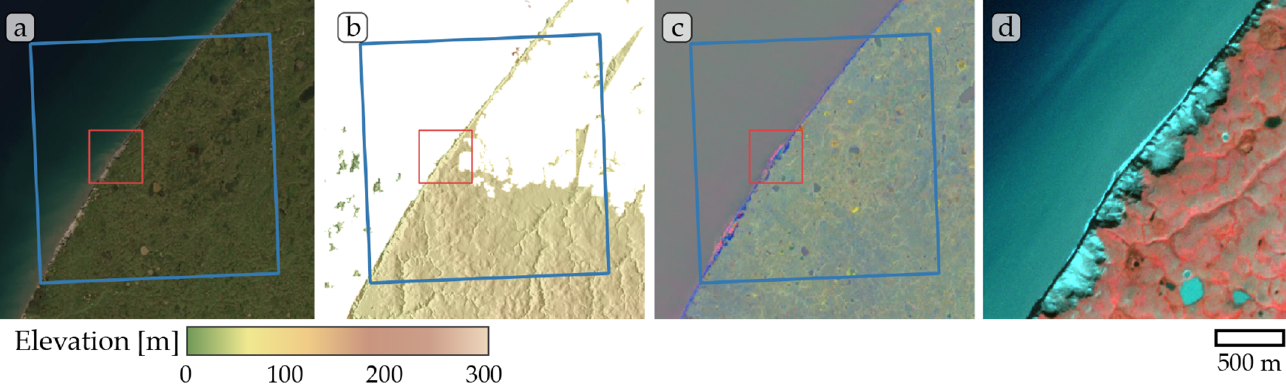
Figure A7. Study site Kolguev Island 02. ( a ) ESRI satellite layer, ( b ) ArcticDEM superimposed with hillshade, ( c ) Tasseled Cap trend visualization, ( d ) PlanetScope satellite image (NIR-R-G) acquired on 19 August 2019. Blue box, 10 × 10 km study site. Red box detailed view of ( d ). Note partially missing ArcticDEM data in ( b ).